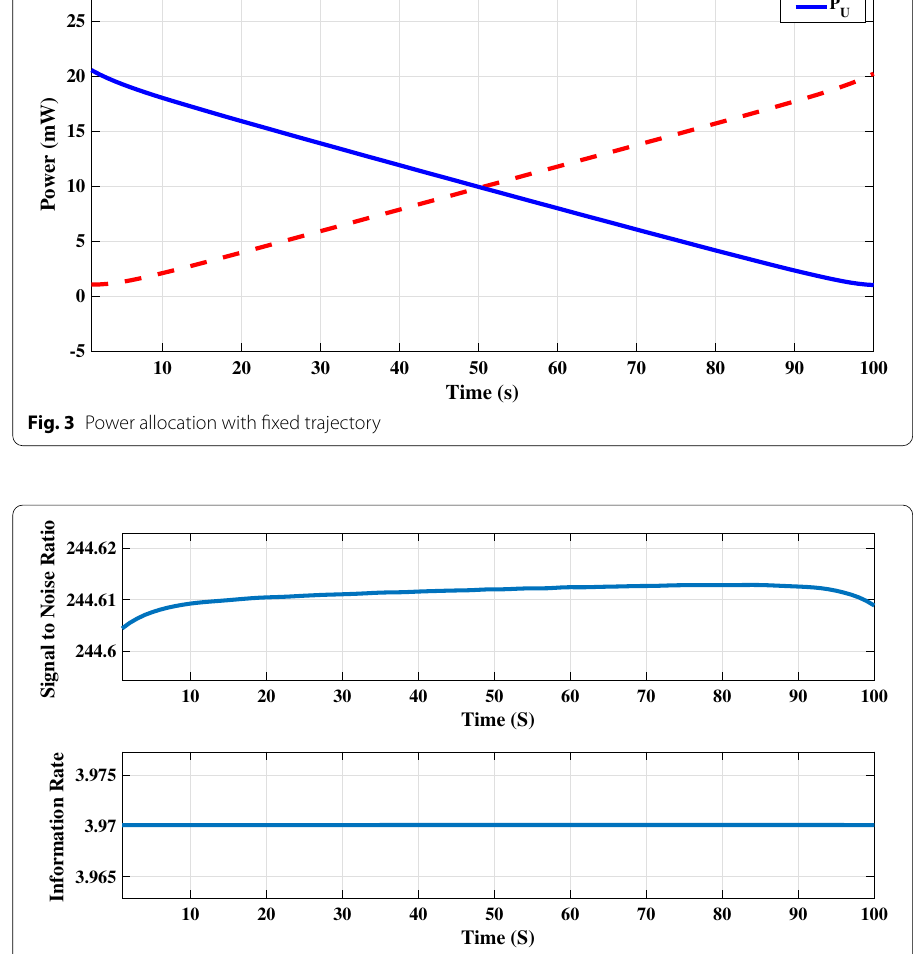
Fig. 4 Optimized SNR and information rate for power allocation with fixed